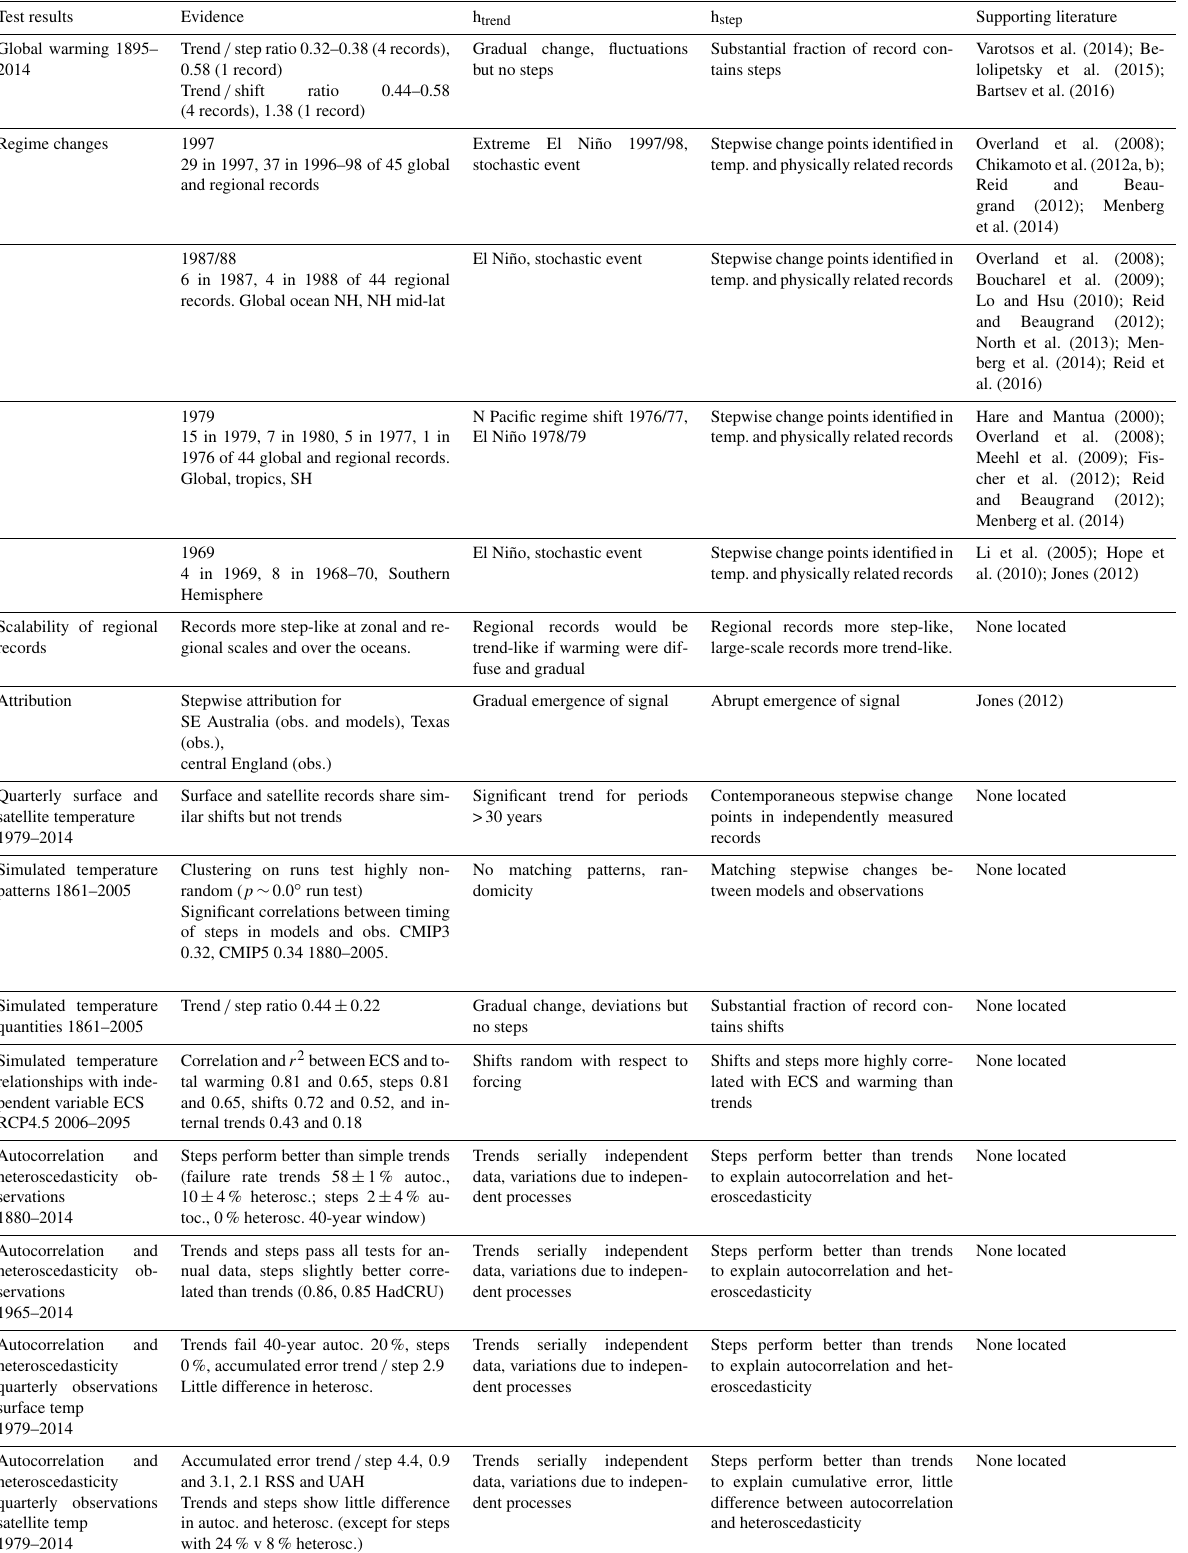
Table 6. Selected test results that distinguish between h trend and h step . The null positions for each are generally not considered diametric. There is no generally accepted null with respect to h trend that references nonlinear change, whereas for H step the null has no significant stepwise change points, or if it does, they are completely random and do not contain an external forcing